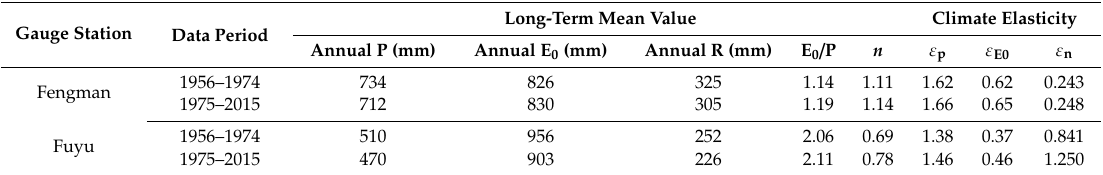
Table 3. Hydroclimatic characteristics for the Fengman Reservoir and Fuyu Station in SSRB.